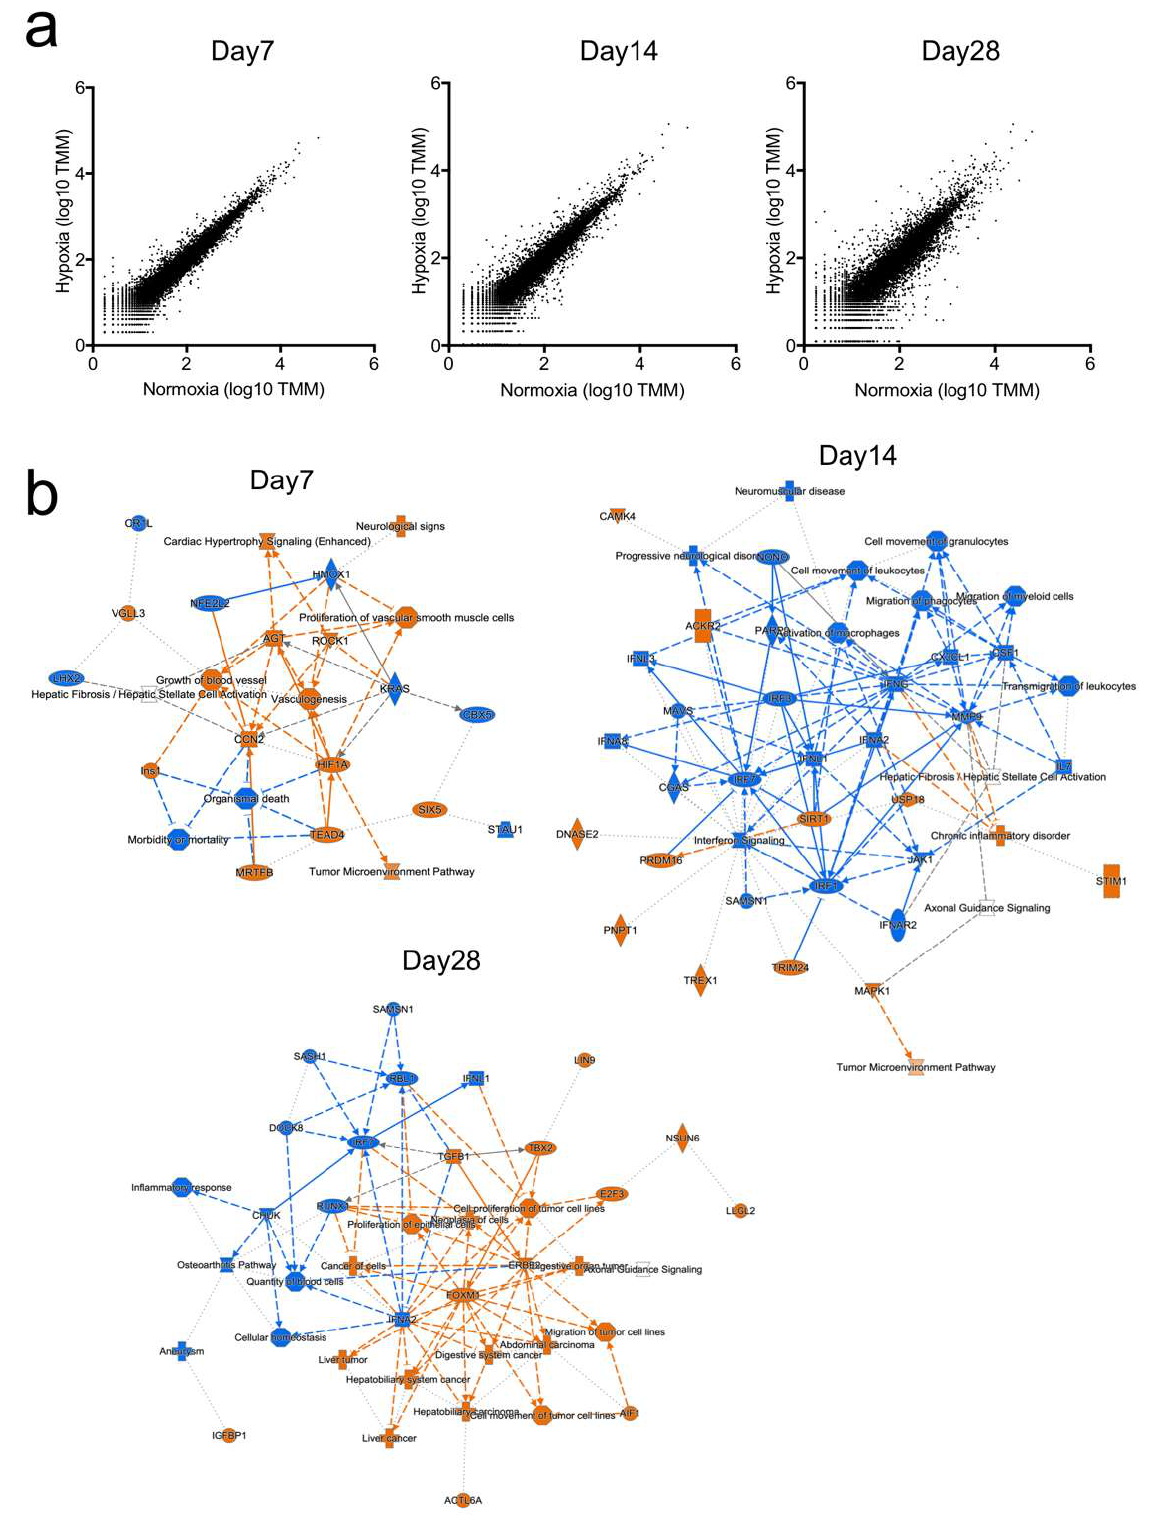
Figure 2. Gene expression in hypo- and normo-VICs. ( a ) Scatter plots of RNA-sequencing data (log 10 TMM) at 7, 14, and 28 d. ( b ) Graphical summaries of IPA pathway analysis at 7, 14, and 28 d. Genes significantly upregulated in normo-VICs and hypo-VICs are denoted in blue and orange, respectively.